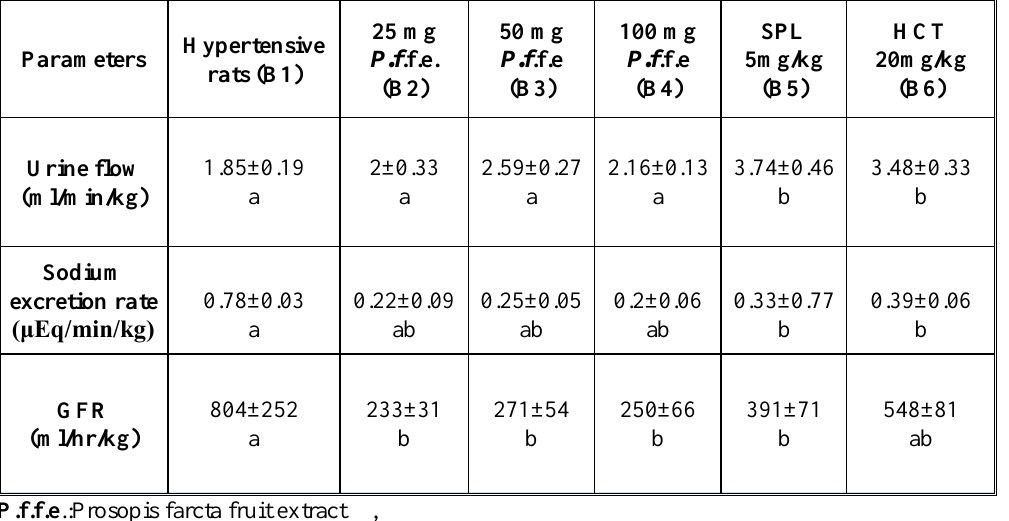
Table 6. Effets of diffèrent doses of P. farcta fruit decoction, spironolactone(5mg/kg) and hydrochlrothiazide (20 mg/kg) on urine flow, sodium excrétion rate, eGFR and in hypertensive